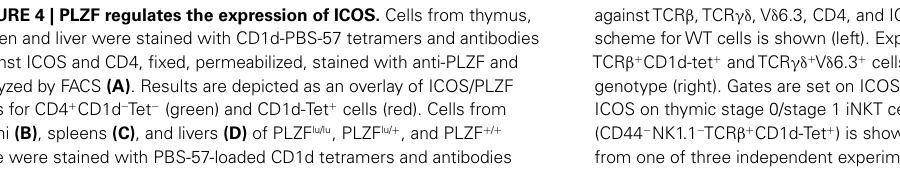
againstTCR β ,TCR γδ ,V δ 6.3, CD4, and ICOS, and analyzed by FACS. Gating scheme forWT cells is shown (left). Expression of CD4 and ICOS on TCR β + CD1d-tet + andTCR γδ + V δ 6.3 + cells is shown for mice with each genotype (right). Gates are set on ICOS int and ICOS hi cells. Expression of ICOS on thymic stage 0/stage 1 iNKT cells (CD44 − NK1.1 − TCR β + CD1d-Tet + ) is shown. (E) Representative FACS plots from one of three independent experiments are